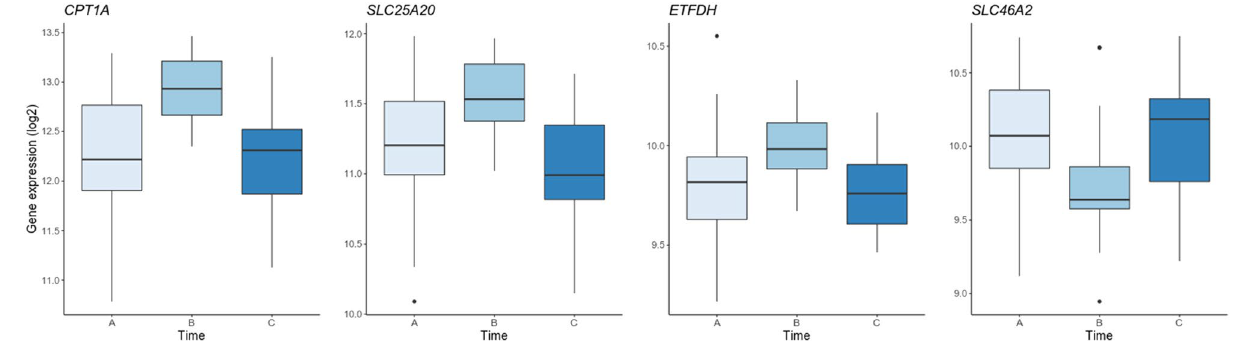
Figure 4. Expression of the four differentially expressed genes, detected both in the paired-sample design (i.e. A vs B) and in the temporal model (i.e. with timepoint of sampling as covariate). On the y-axis the gene expression in transcripts per million (log2) and on the x-axis the three time points (i.e. A = during attack, B = after treatment, C =